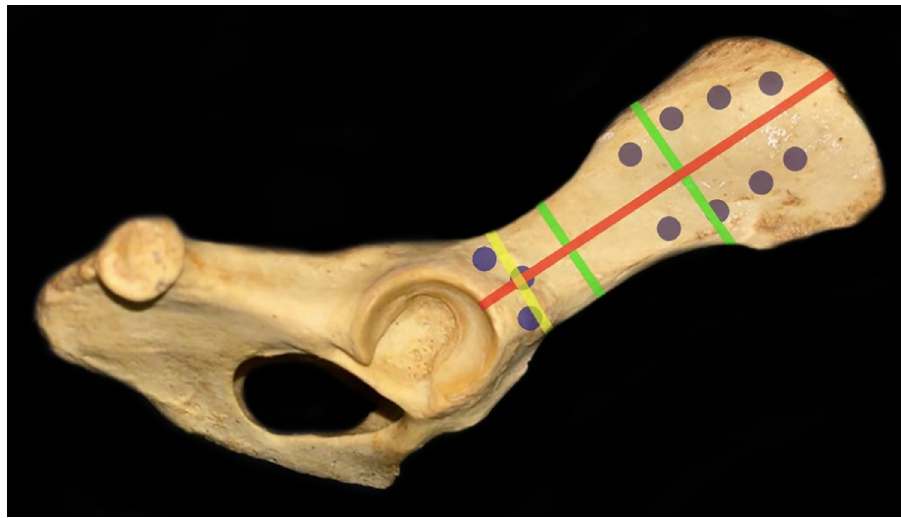
Fig 1. Schematic representation of the landmarks used for pelvic assessments performed on dog cadavers to ensure fitness and determine optimal shape dimensions of the novel canine iliac plate.